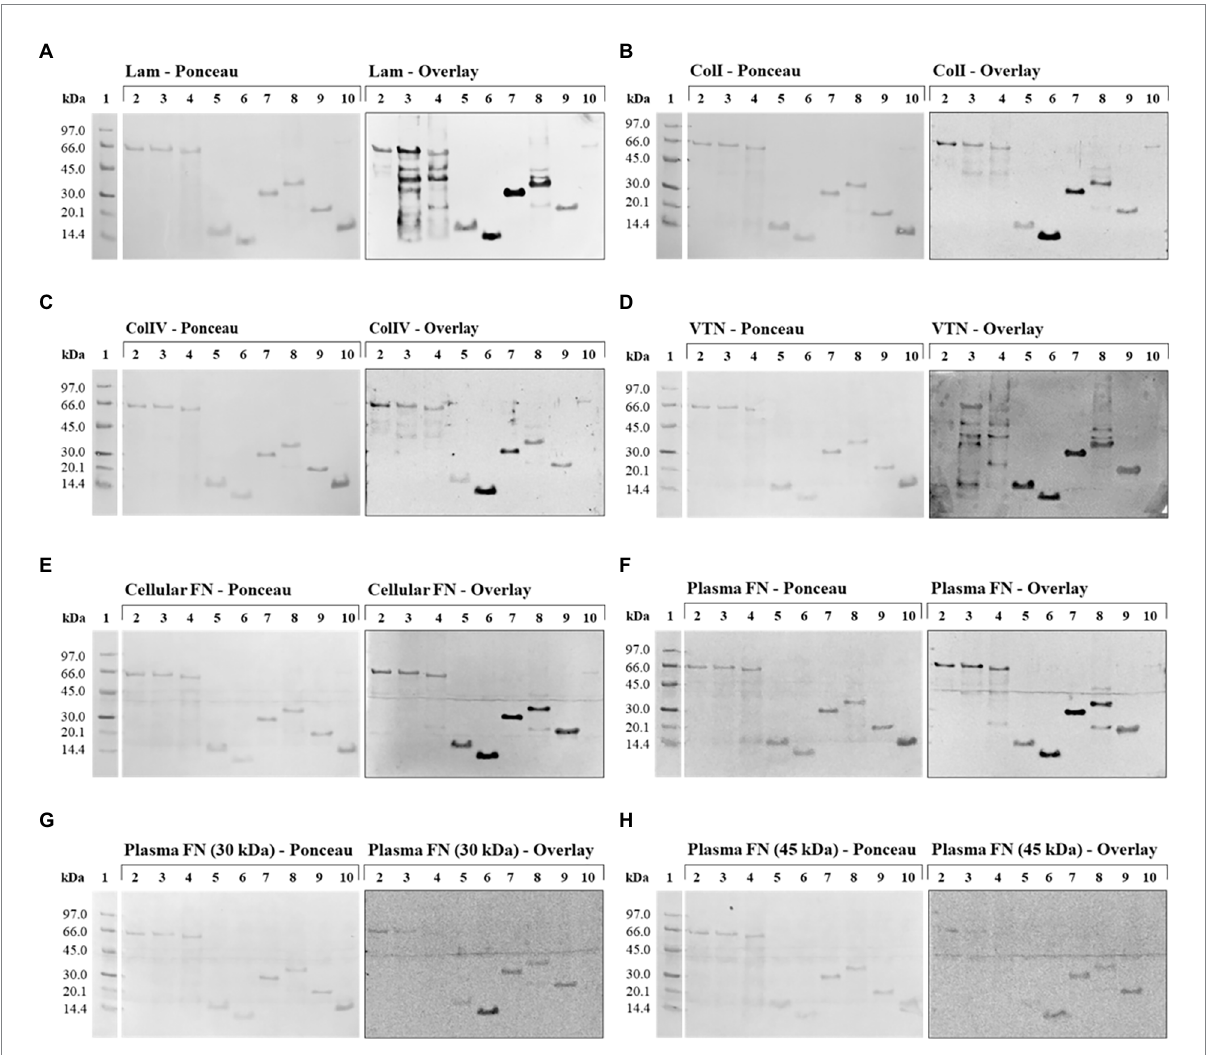
FIGURE 5 Far Western Blotting (Overlay) assay with LIC10778, LIC12339, and LIC10870 recombinant proteins, and their interaction with ECM proteins. On the left are the nitrocellulose membranes stained with Ponceau S, after SDS-PAGE fractionation and transfer, with the recombinant proteins in the following order: LIC12339F (lane 2), LIC10870F (lane 3), LIC10778F (lane 4), LIC10778_LecB (lane 5), LIC10778_Phg (lane 6), LIC10778_D1 (lane 7), LIC10778_Cards (lane 8), and LIC10778_Ct (lane 9). In lane 10, LigA (63 kDa) and LIC10301 (13 kDa) were added as positive and negative controls, respectively. On the right are the chemiluminescent signals observed after incubation of the corresponding nitrocellulose membranes with 10 μ g/ ml of the proteins: laminin (Lam, A) , collagen I (ColI, B) , collagen IV (ColIV, C) , vitronectin (VTN, D) , cellular fibronectin (cellular FN, E) , plasma fibronectin (plasma FN, F) or 30 kDa (G) and 45 kDa (H) proteolytic fragments of plasma fibronectin, followed by specific antibodies to each of these proteins. Lane 1: molecular mass marker. Results were obtained from two independent